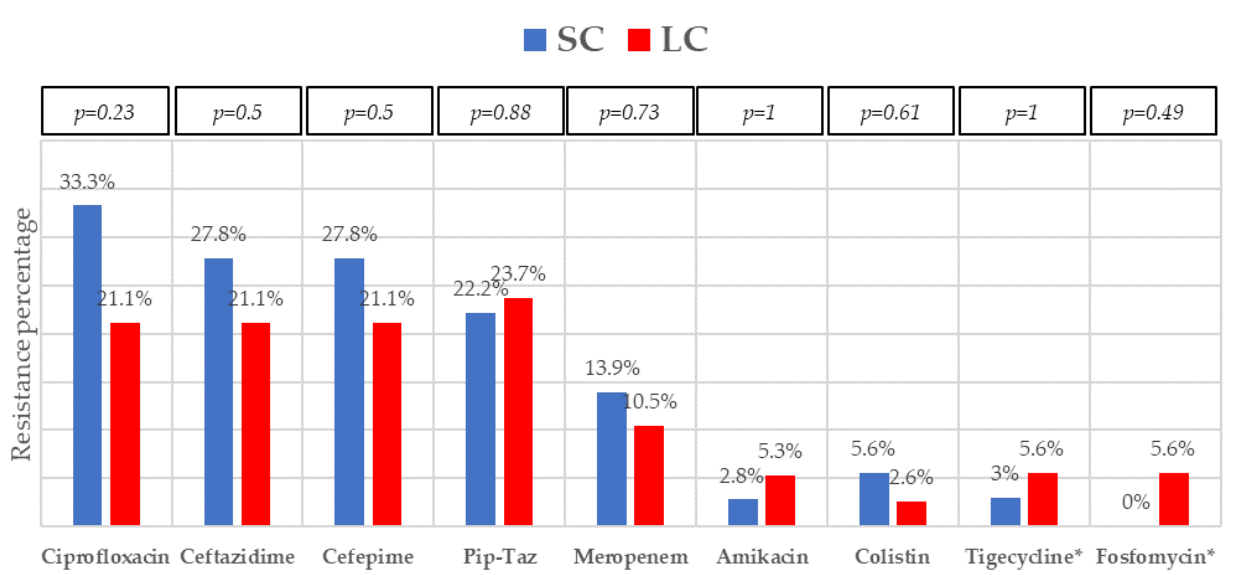
Figure 2. Resistance mechanisms of Gram-negative bacilli bacteremia treated with short-course (SC) or long-course (LC) antibiotic therapy. The proportion of extended- spectrum β -lactamases (ESBL), KPC carbapenem-producing ( bla KPC), and multidrug-resistant Pseudomonas aeruginosa. p -values obtained by Fisher’s exact test.